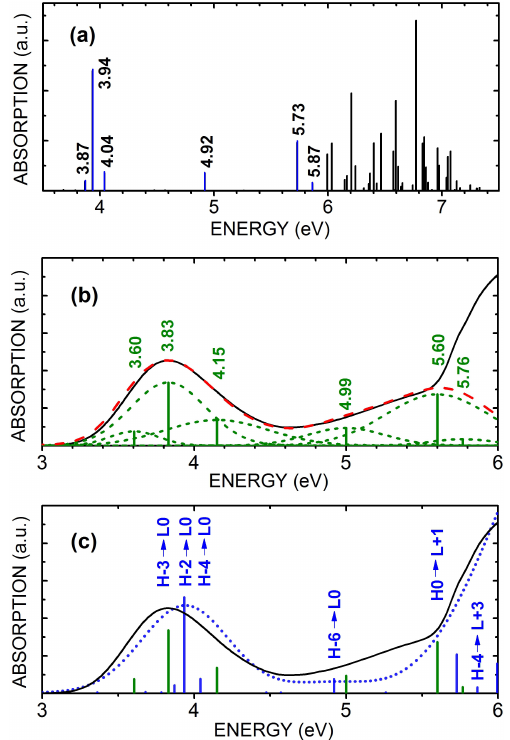
( a ) TD-DFT calculated UV-vis optical absorption of benznidazole in water (PCM model) at the highest concentration 146.0 µmol/L (HC); ( b ) deconvolution of the the measured UV-vis optical absorption of benznidazole in water (PCM model) for the HC case using six Gaussian curves (dashed lines), with corresponding mean energies indicated by vertical bars; ( c ) a comparison between the measured UV-vis optical absorption of benznidazole in water (PCM model) for HC (solid black line) and the TD-DFT calculated spectrum (short dotted blue line). The mean energy positions for each Gaussian peak fitting the measured UV-vis spectrum are indicated by green vertical bars, while the main TD-DFT transition energies are depicted using blue vertical bars. For the latter, the highest relevant HOMO and LUMO orbitals involved in the excitations are